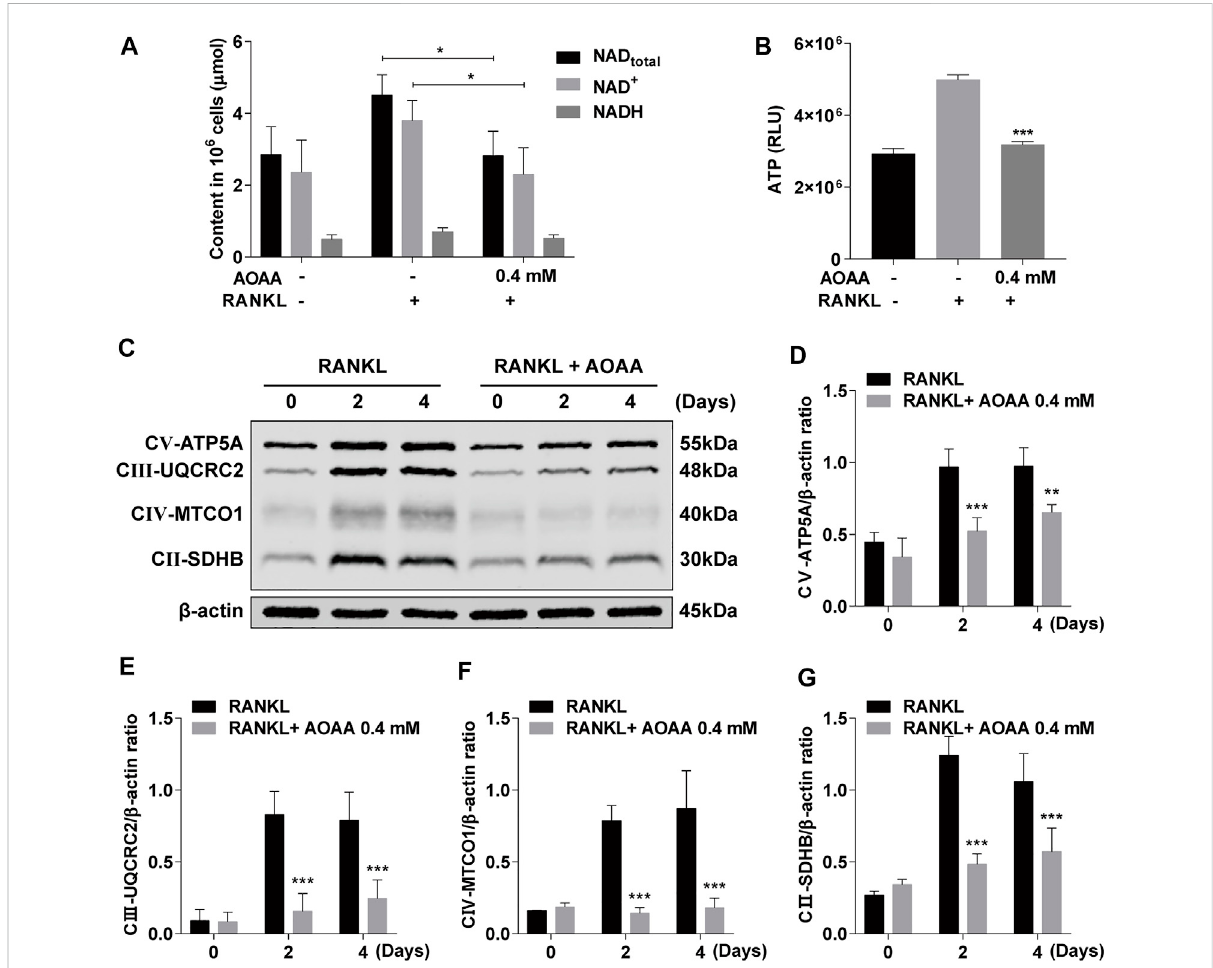
FIGURE 4 AOAA attenuates mitochondrial OXPHOS and reduces ATP production. (A) The relative levels of NAD + and NADH were detected using the NAD + /NADH assay kit. Student ’ s t -test was used. (B) The relative levels of ATP were detected using the enhanced ATP assay kit (compared with AOAA − RANKL + group). One-way ANOVA was used. (C) Representative western blot images of the effects of AOAA on mitochondrial OXPHOS complexes (C Ⅴ -ATP5A, C Ⅲ -UQCRC2, C Ⅳ -MTCO1, C Ⅱ -SDHB). (D – G) Quanti fi cation of the ratios of band intensity of C Ⅴ -ATP5A, C Ⅲ